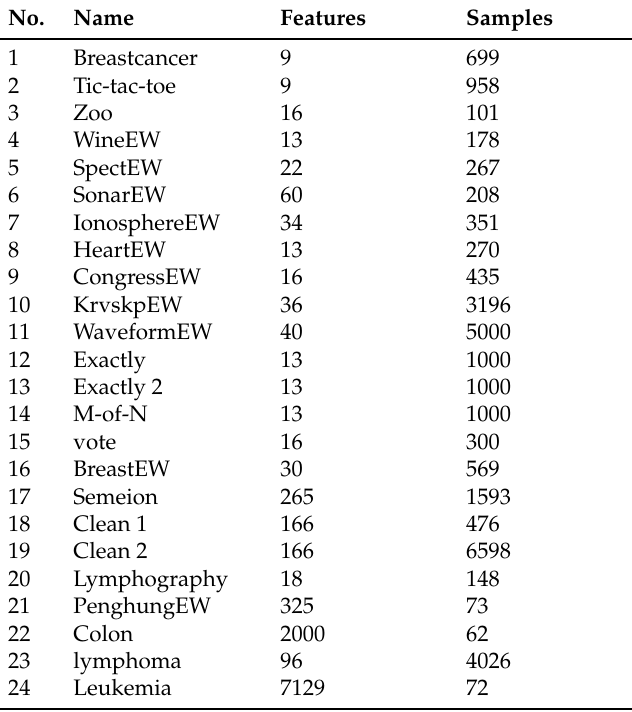
Table 2. List of datasets used in the experiments